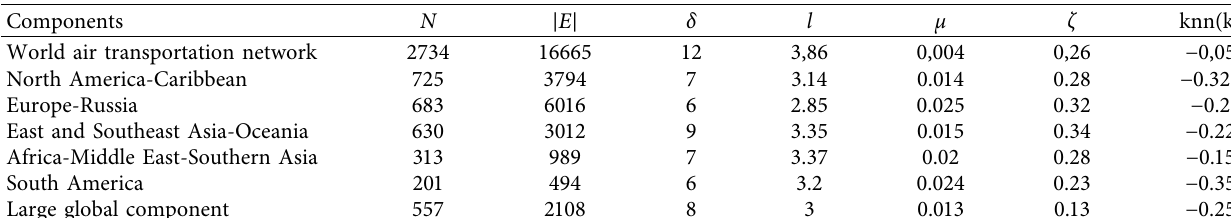
Table 1: Basic topological properties of the world air transportation network, the fve large local components, and the largest global component. N is the network size. | E | is the number of edges. δ is the diameter. l is the average shortest path length. μ is the density. ζ is the transitivity, also called the global clustering coefcient. knn ( k ) is the assortativity, also called the degree correlation coefcient.